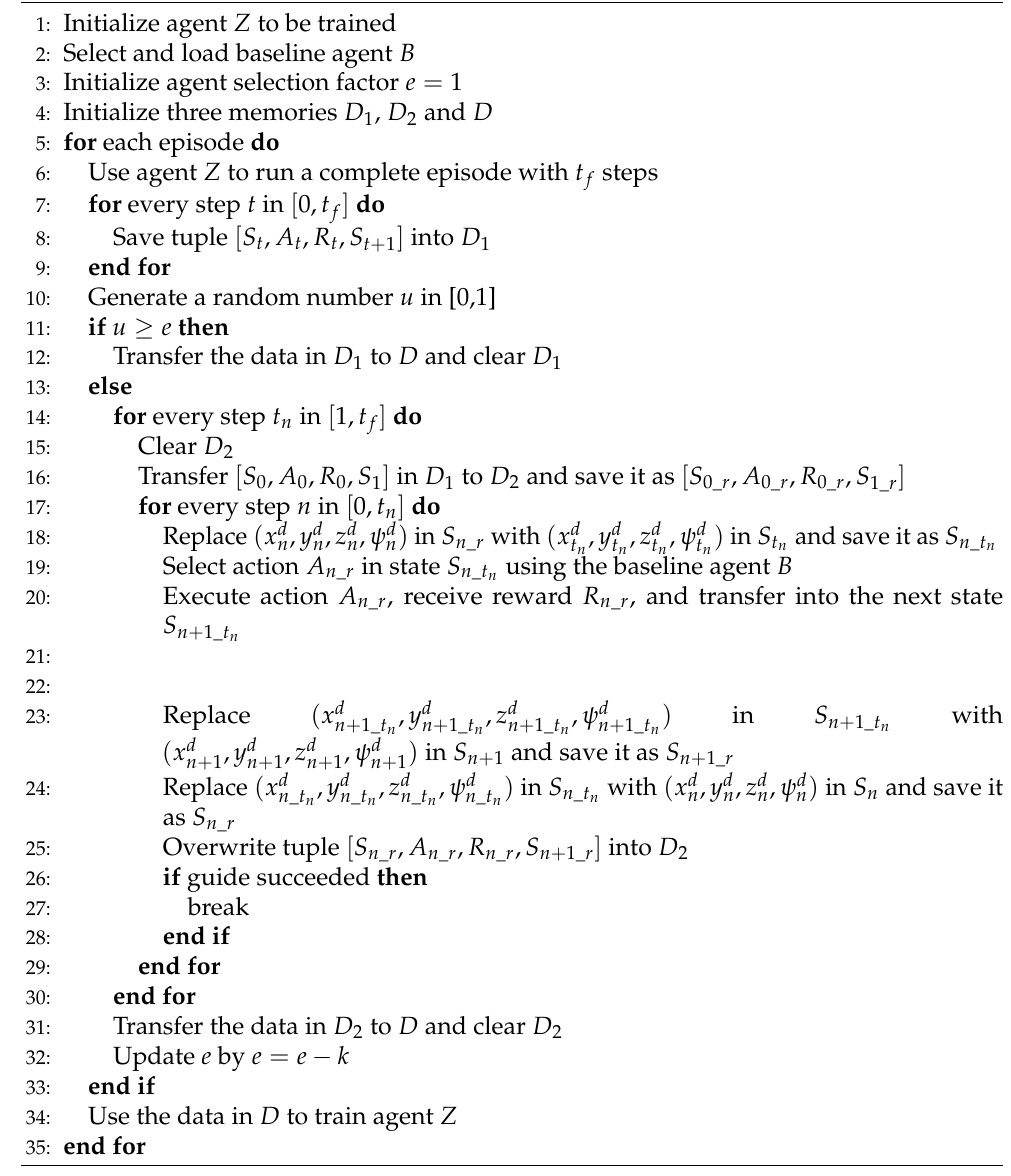
Algorithm 1 Destination Position Prediction-Based Policy-Reuse